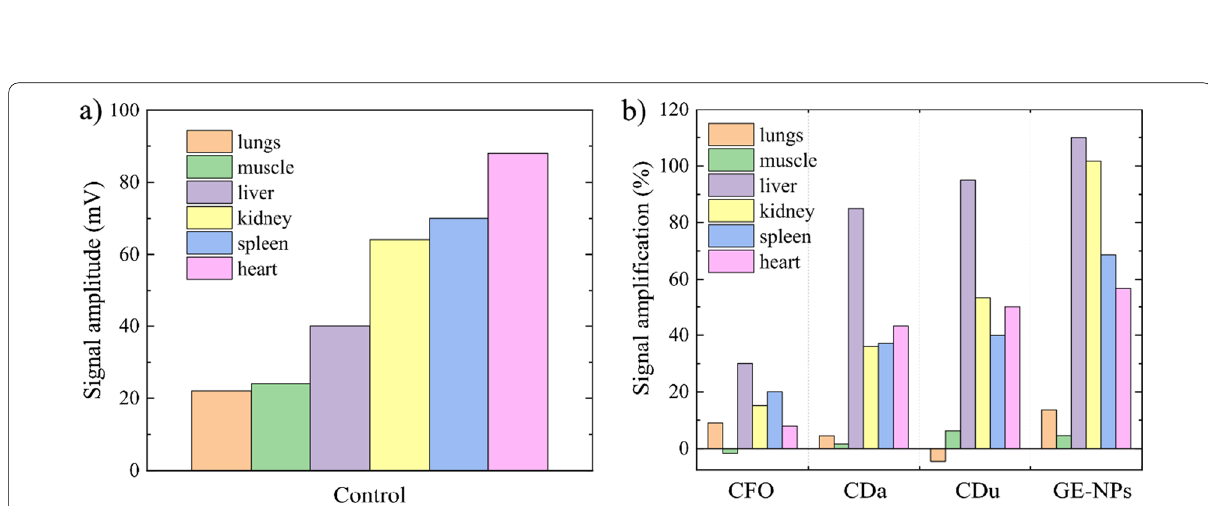
Fig. 6 Comparative diagram of photoacoustic signals in different tissues. a Basal endogenous photoacoustic signal of the tissues without nanoparticles. b Photoacoustic signals induced by presence of different nanoparticles: CFO: carbon flurooxide nanoparticles; CDa: carbon nanodots from β -alanine; CDu: carbon nanodots from urea-citric acid; GE-NPs: glucose-ethylenediamine